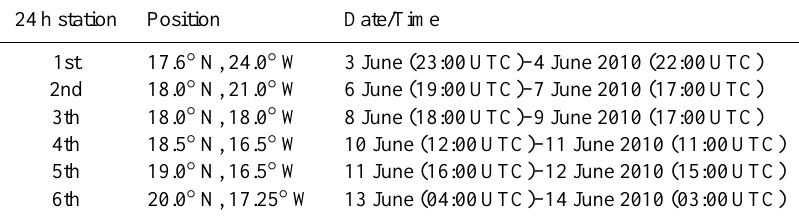
Table 1. 24h stations: position and